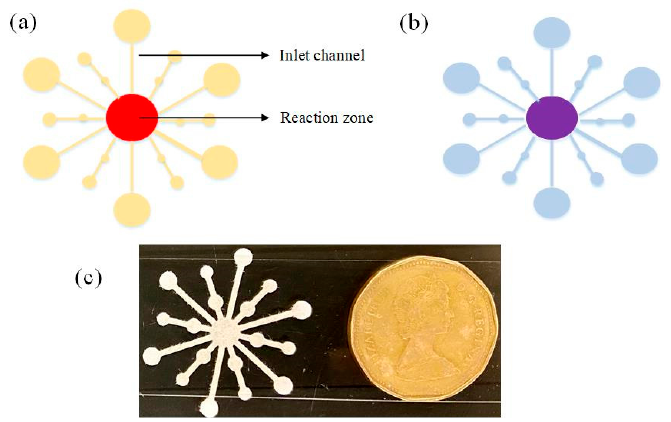
Figure 1. Schematic of the microfluidic paper biosensor depicting channels and reaction zones ( a ) color of reaction zone before the introduction of gentamicin and ( b ) color change from red to purple in the reaction zone after interaction. ( c ) The paper biosensor the size of a dollar coin.